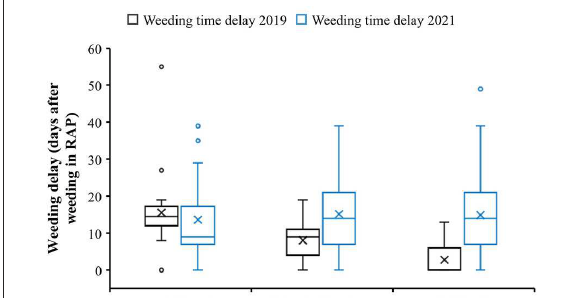
FIGURE3 Weeding time delay compared with weeding time under recommended agronomic practices (RAP) during (2019) and after (2021) joint experimentation. Weeding time delay was calculated as the difference in weeding time under FP and RAP. Weeding time delay 2019: weeding delay during joint experimentation in 2019; Weeding time delay 2021: weeding delay after joint experimentation in 2021; Lower- ( n = 28), middle- ( n = 29) and top- ( n = 29) yielding farmers are